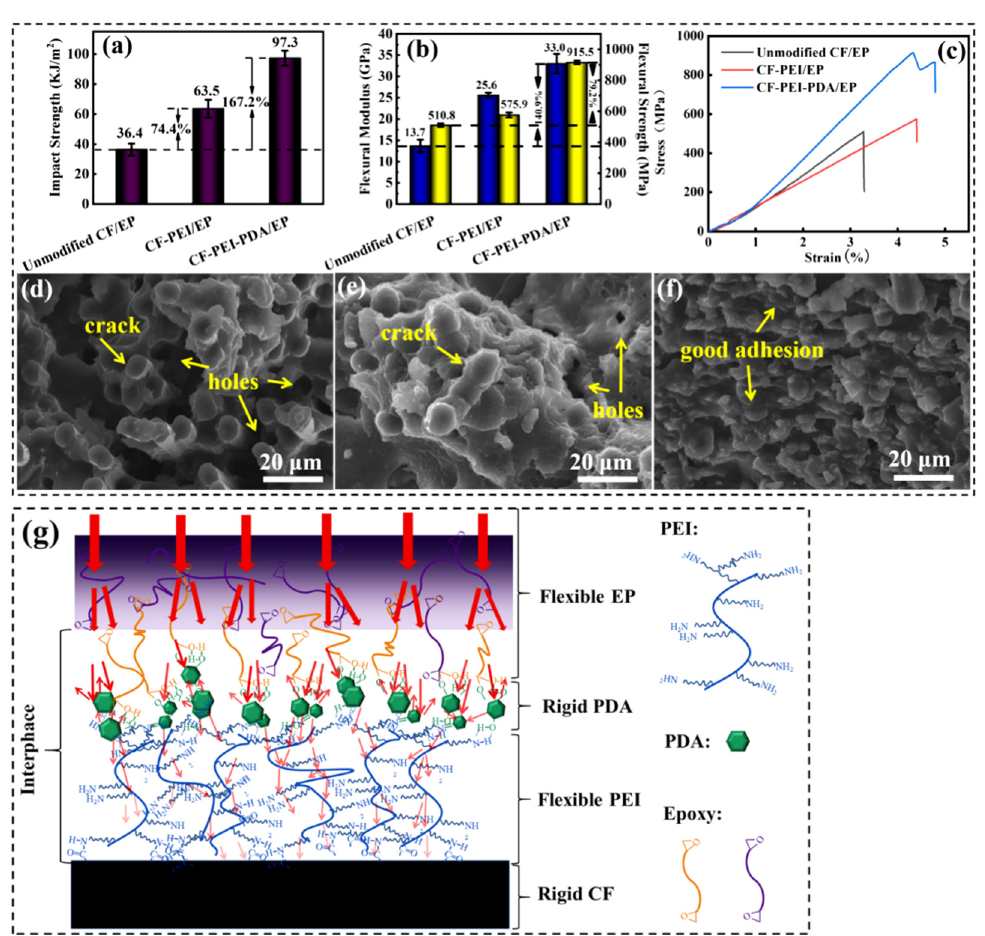
Figure 7. ( a ) Impact strength; ( b ) Flexural strength and flexural modulus; ( c ) Stress–strain curves of different CF/EP composites. SEM images of the fracture morphology for: ( d ) Unmodified CF/EP; ( e ) CF-PEI/EP and ( f ) CF-PEI-PDA/EP; ( g ) Schematic diagram of the strengthening mechanism of CF-PEI-PDA/EP.